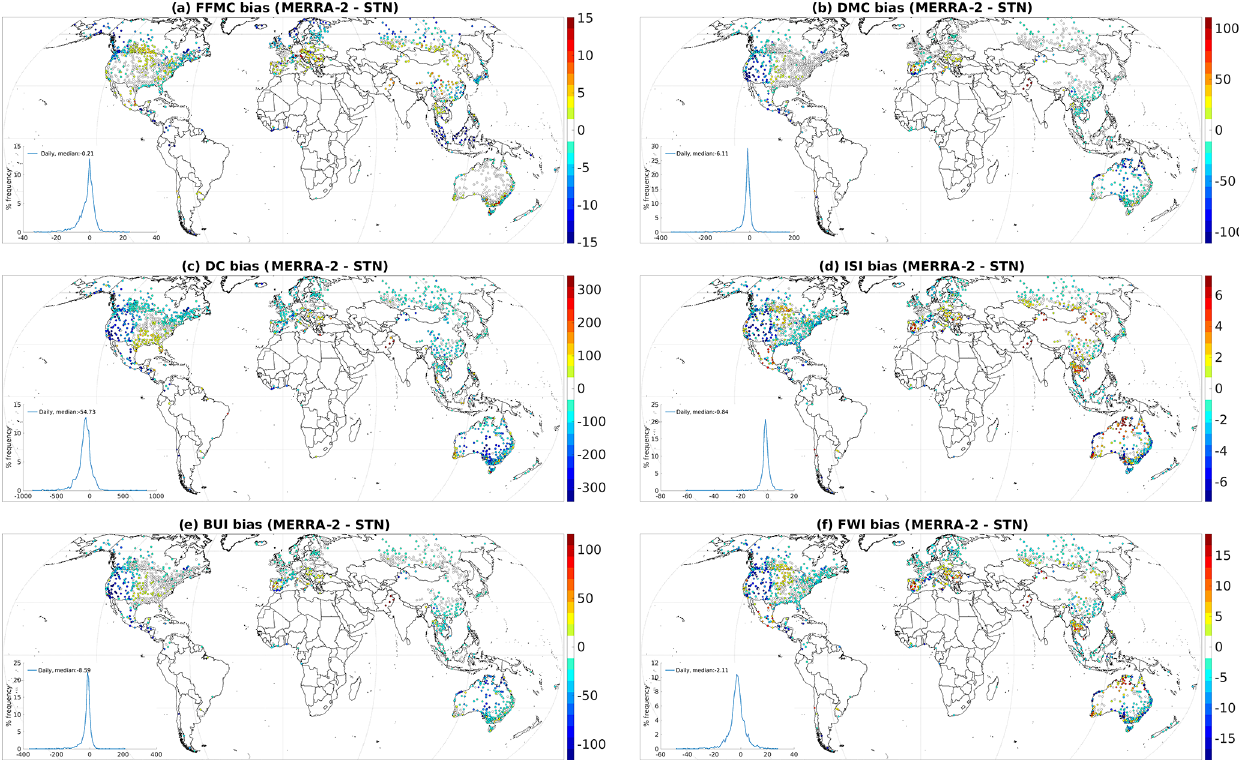
Figure 5. 2004–2018 bias between Fire Weather Index (FWI) components calculated from MERRA-2 and from weather stations, only over the local 4-month fire season. Table 2. Weather input and FWI statistics for 1746 weather stations and MERRA-2 reanalysis fields sampled at station locations for 2004– 2018. The first row in the table is the mean for each weather input from the weather station data (STN MEAN is station mean), and the second row is the mean MERRA-2 bias relative to the station data. The first column is the mean FWI value across weather stations, and the second column is the mean MERRA-2 bias relative to the station data. The interior table entries in italics are the correlations (for p < 0 . 05 only) between the FWI component biases and the weather input biases across stations. Means and biases at each station are calculated only over the local 4-month fire season. SNOWD is the percentage of days with snow on the ground, and FIRESEASON is the percentage of days during which the FWI calculations are